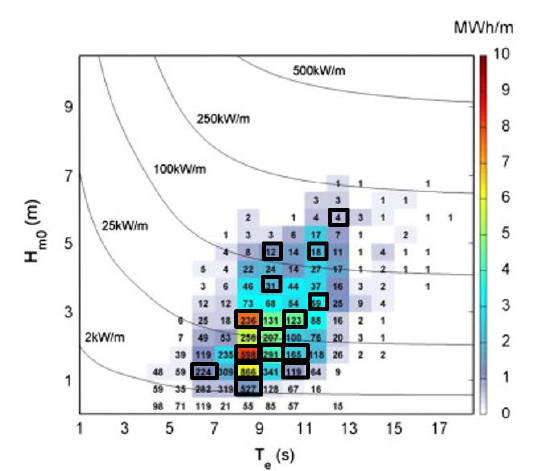
Fig. 2. Traditional binning method of directional annual average scatter diagram of the wave resource at the site considered for a breakwater OWC. All of the 15 bins selected are circled in black for later use in Marinet2 tank testing for an OWC